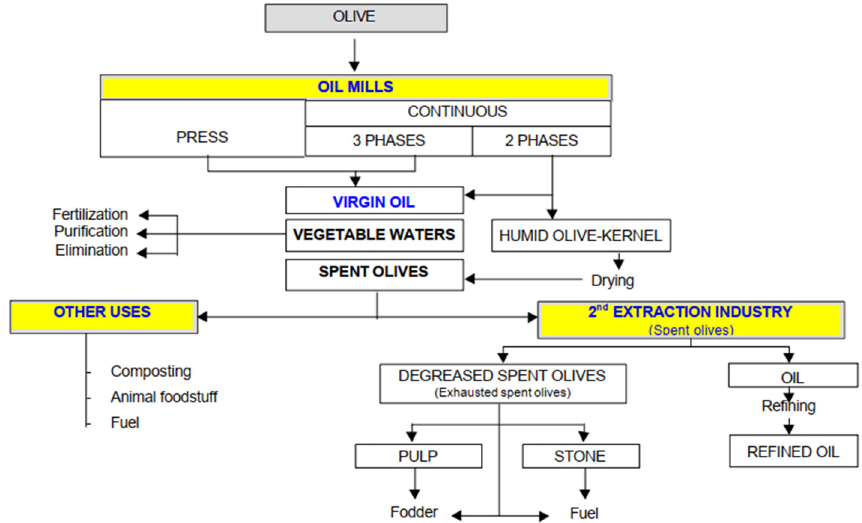
Figure 1. General vision on products, by-products, and residues in the olive oil industry.